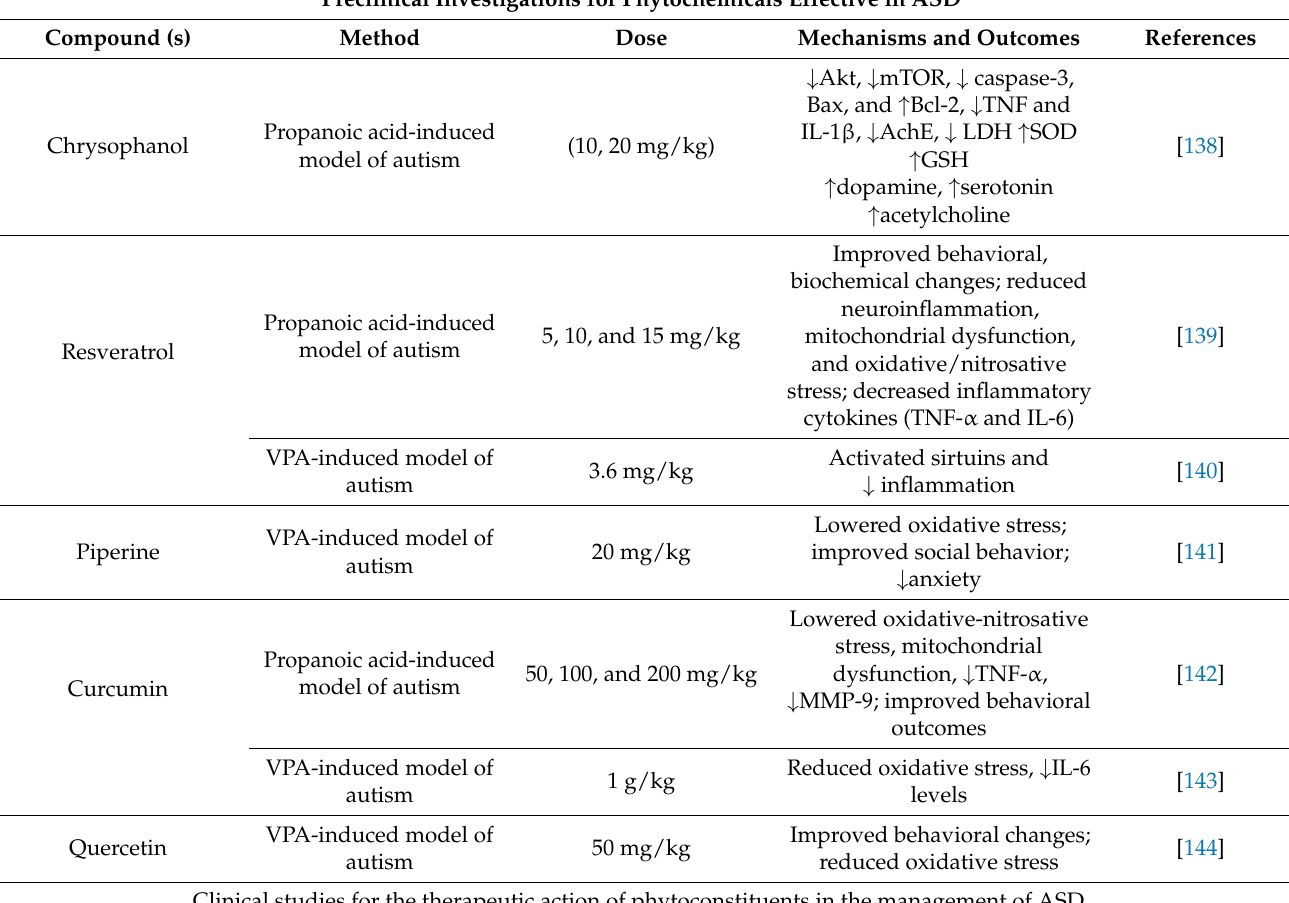
Table 2. A summary of preclinical and clinical investigations of plant bioactive compounds in management of